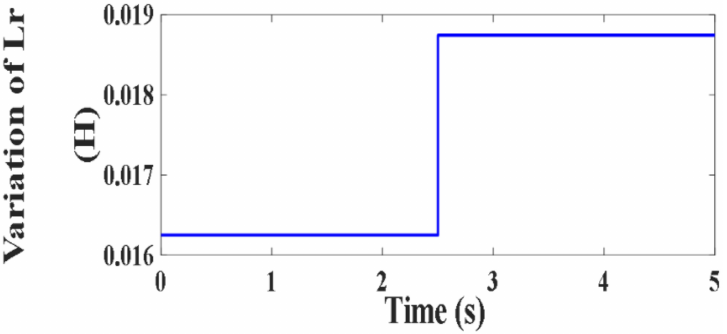
Figure 108. Variation of L r